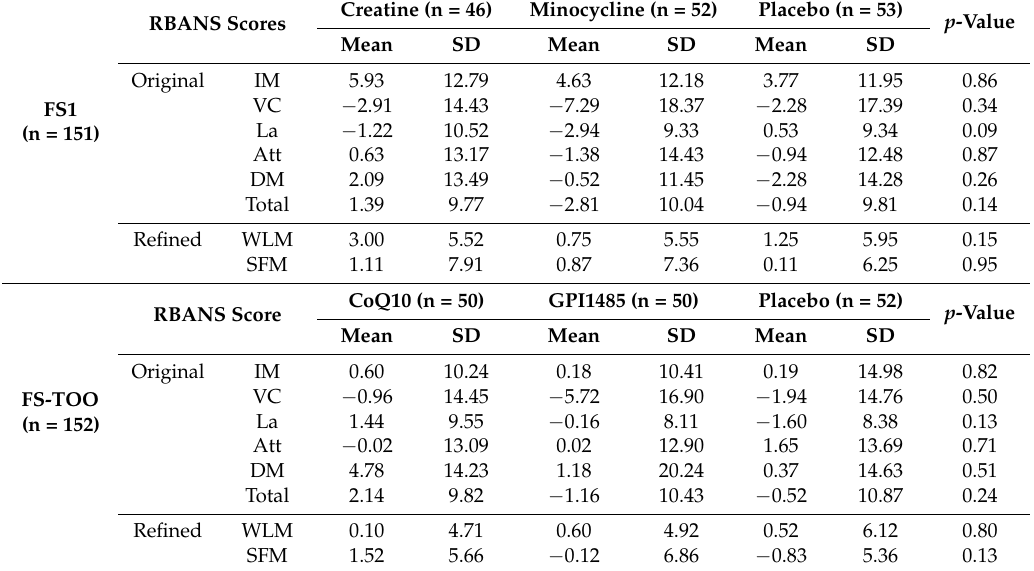
Table 2. Preliminary comparisons of change from baseline on cognitive abilities among treatment groups using the Repeated Battery for the Assessment of Neuropsychological Status (RBANS) scores: original vs.